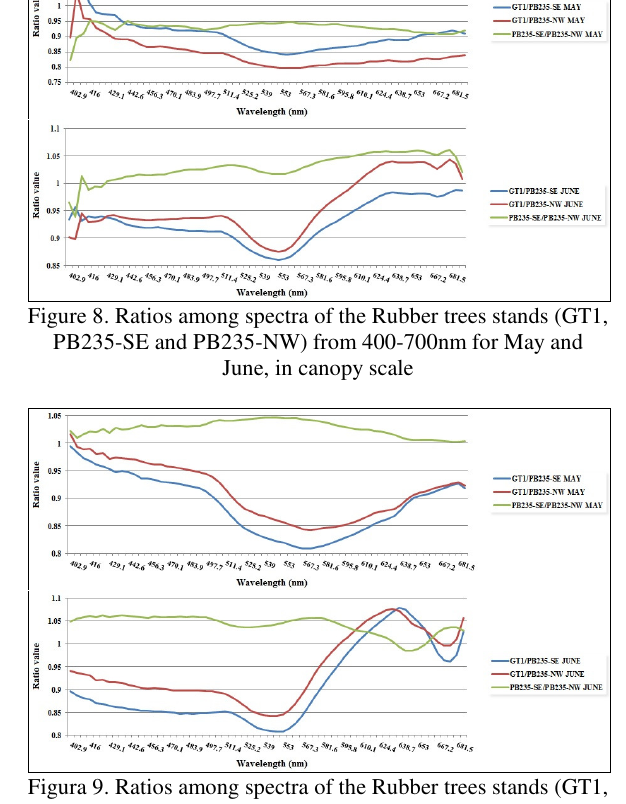
Figure 4. Spectral behaviour in canopy scale from 450 to 480nm, for May and June, of the Rubber trees stands: GT1,